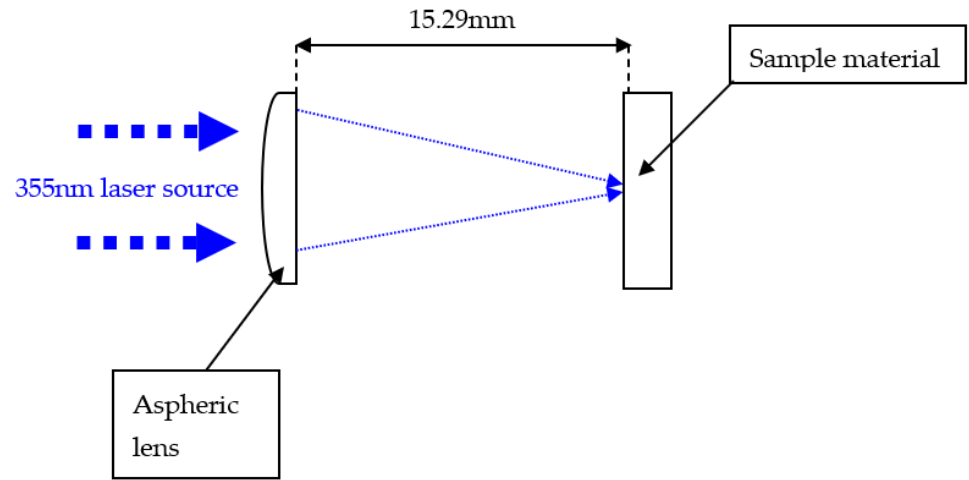
Figure 1. Setup for the direct write modification of the surface of the transparent materials.